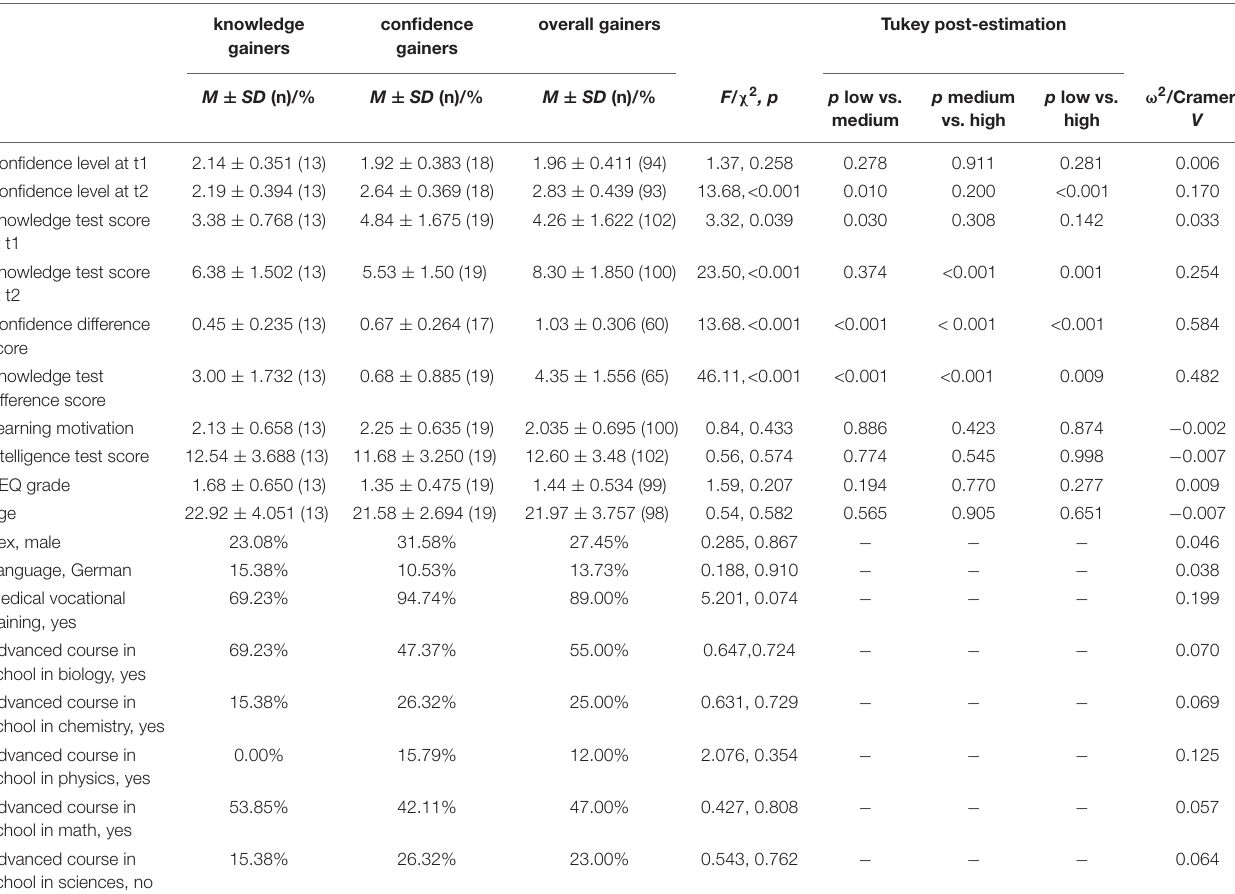
TABLE 4 | Differences between the three profiles regarding changes in confidence and knowledge.